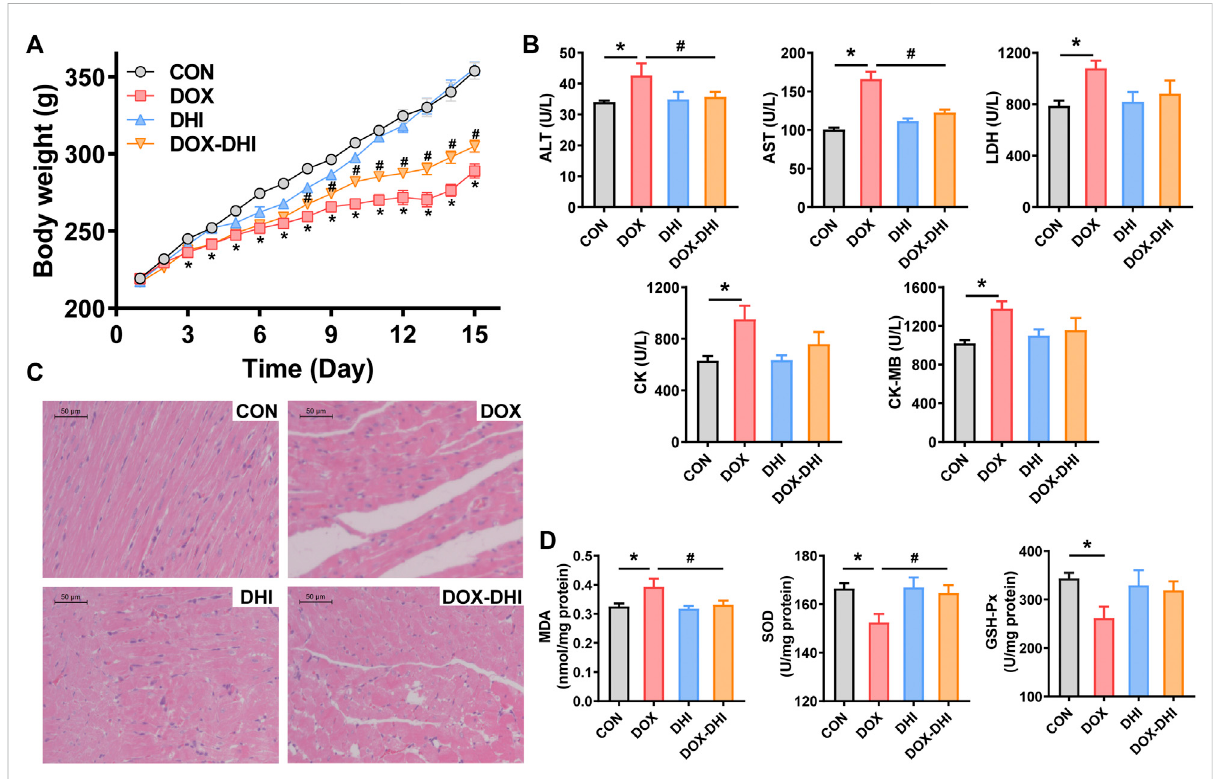
FIGURE 3 Protective effect of DHI on DOX-induced cardiotoxicity in rats. (A) Body weight changes of rats in each group. (B) Detection of serum biochemical markers (ALT, AST, LDH, CK, and CK-MB). (C) Histological alterations in heart tissue (10 × 10). (D) Measurement of oxidative stress markers (MDA, SOD, and GSH-Px) in heart tissue. CON: normal control; DHI: Danhong injection; DOX: doxorubicin; ALT: alanine aminotransferase; AST: aspartate aminotransferase; LDH: lactate dehydrogenase; CK: creatine kinase; CK-MB: creatine kinase isoenzyme; MDA: malondialdehyde; SOD: superoxide dismutase; GSH-Px: glutathione peroxidase. Data are expressed as mean ± SEM (CON and DHI, n = 8; DOX and DOX – DHI, n = 12). * p < 0.05 versus the CON group. # p < 0.05 versus the DOX group.